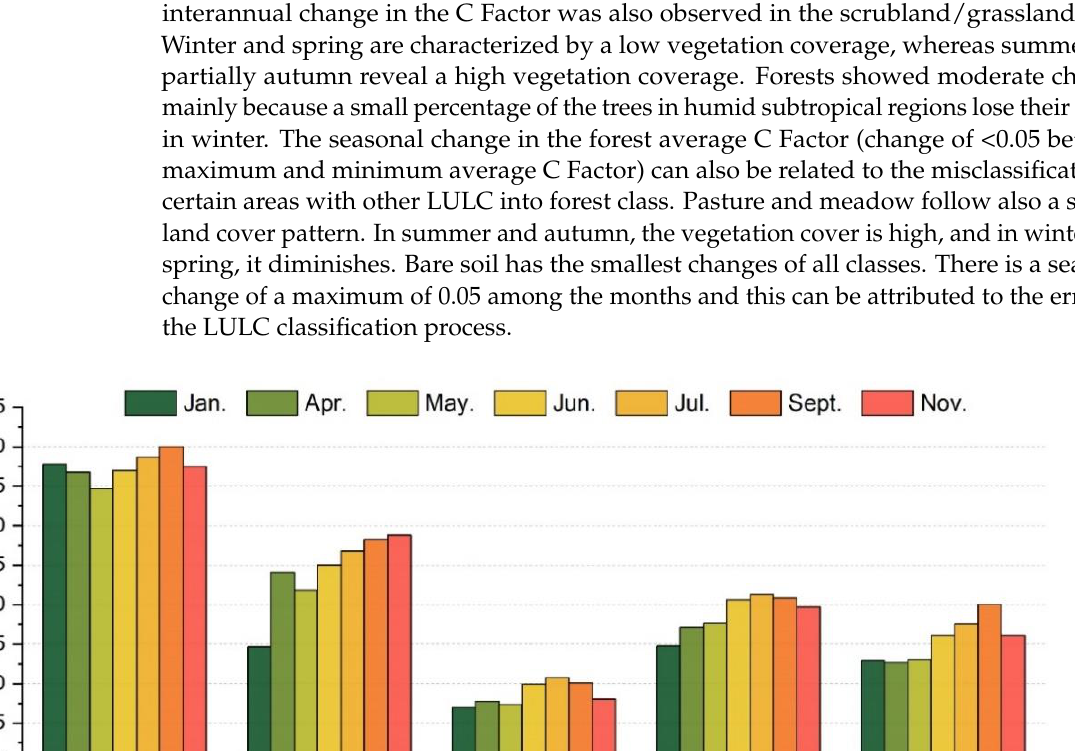
Figure 11. Spatial distribution of C factor for January ( left ) and July ( right ). The difference among the seasons can be clearly observed also in the spatial distribu- tion of the C Factor (Figure 11). The western area of the catchment, where most of the agriculture activity is located, shows higher values in July than in January. In July (winter period), the soil is mostly uncovered and has an average C Factor greater than 0.3. While in January (summer and wet season), vegetation covers most of the catchment area. Only sporadic parts of the agricultural areas, which were not seeded, had high C Factor values also in January. 3.2. R Factor